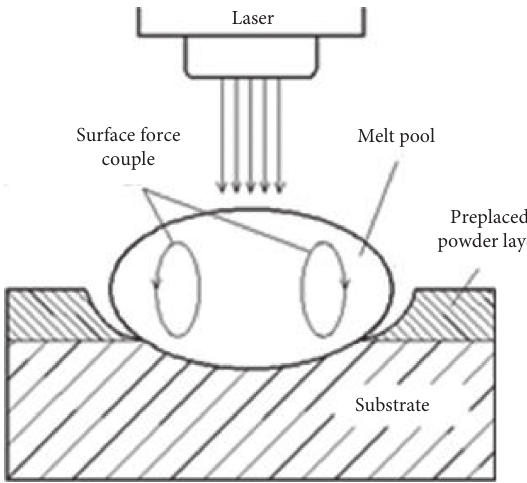
Figure 3: The diagrammatic sketch of the melt pool when the substrate slightly